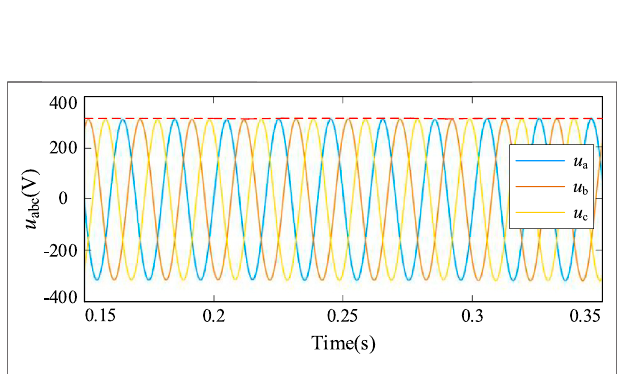
FIGURE 9 | Output voltage of the inverter under the proposed control strategy (voltage